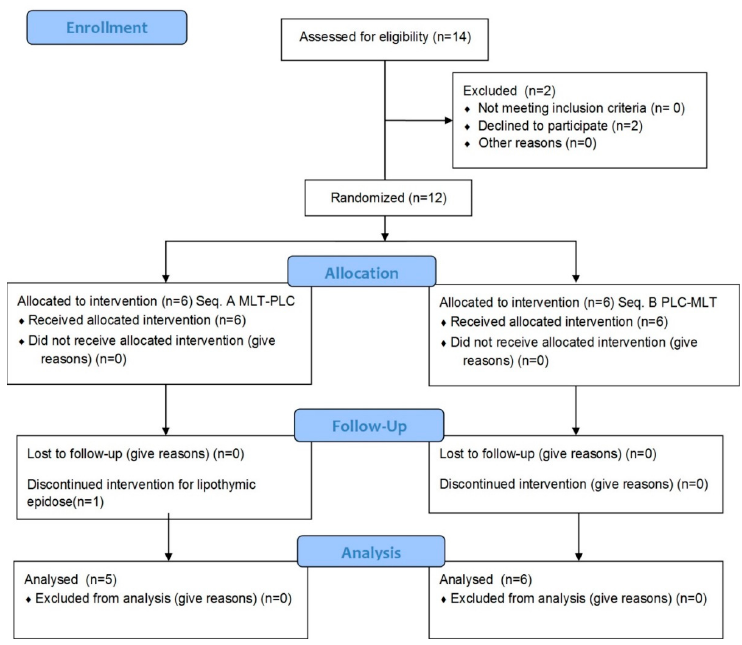
Figure 1. CONSORT (consolidated standards of reporting trials) flow chart of the study design. Table 1. Demographics, anthropometric characteristics and dietary habits of participants ( n = 12).